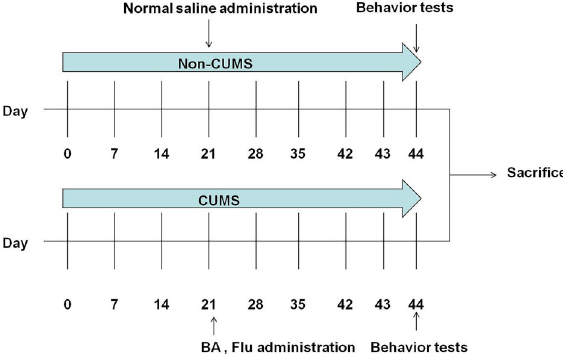
Figure 1. Schematic representation of the experimental proce- dure for chronic unpredictable mild stress (CUMS) depression model and treatments. BA: baicalin; Flu: fl